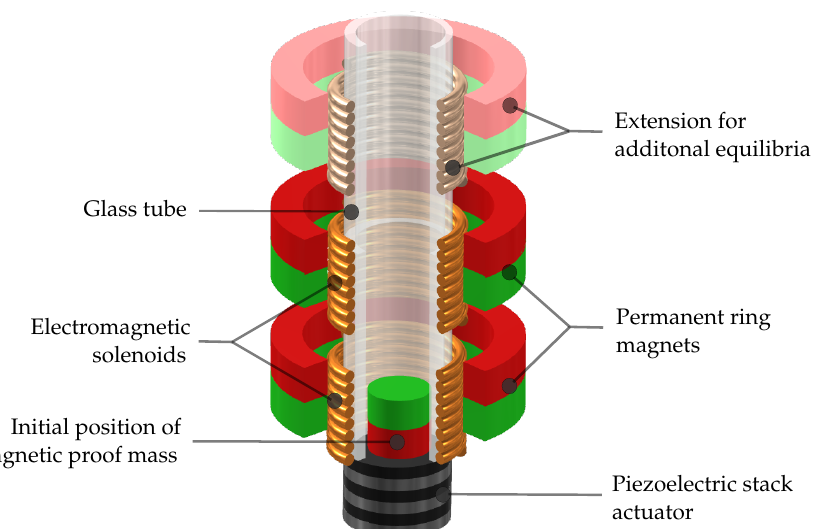
Figure 1. The multistable microactuator consists of a movable, cylindrical magnet within a guiding glass tube, a piezoelectric stack actuator (kick actuator), permanent magnets and electromagnets (catch actuators). The transparent part depicts a possible extension to a third levitating